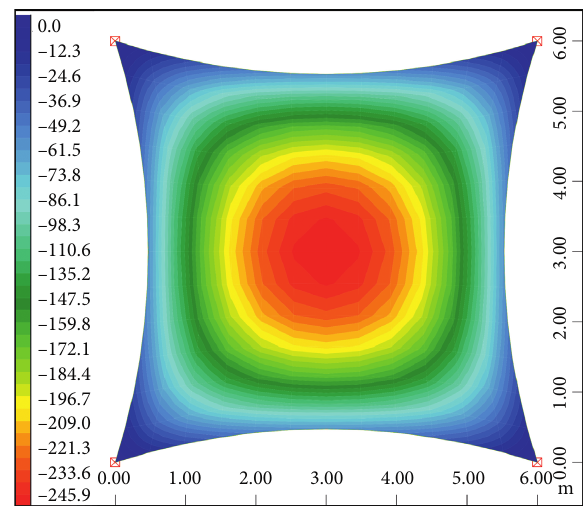
Figure 6: Membrane deflections of the initial model in global Z direction for 0.6 kN/m 2 snow load (mm).